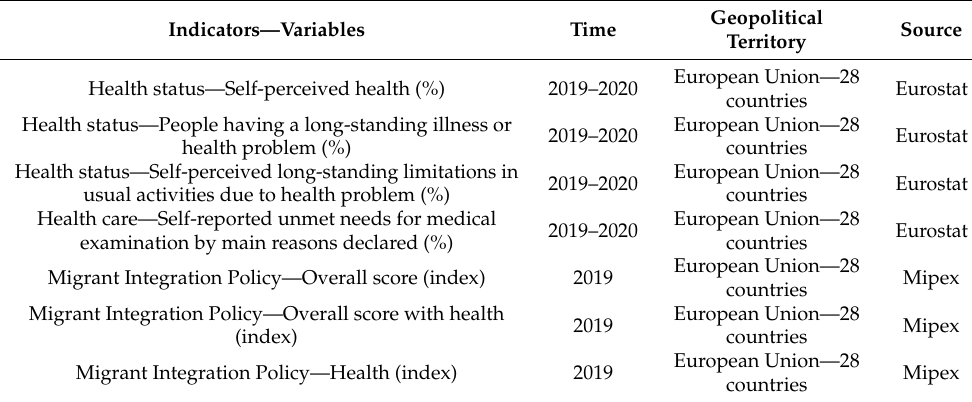
Table 1. Statistical indicators, time, geopolitical territory and source of data.